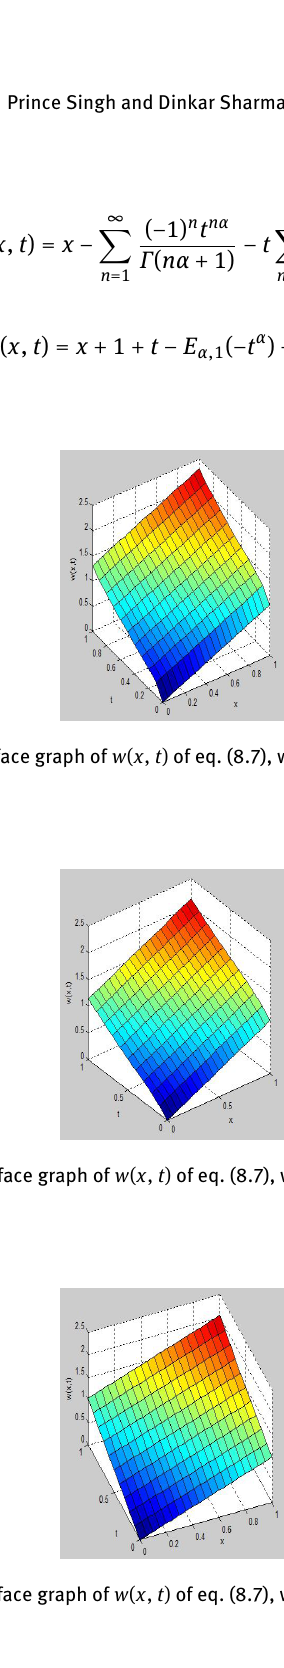
When α = 1, the exact solution of (8.7) is w ( x , t ) = x + t .